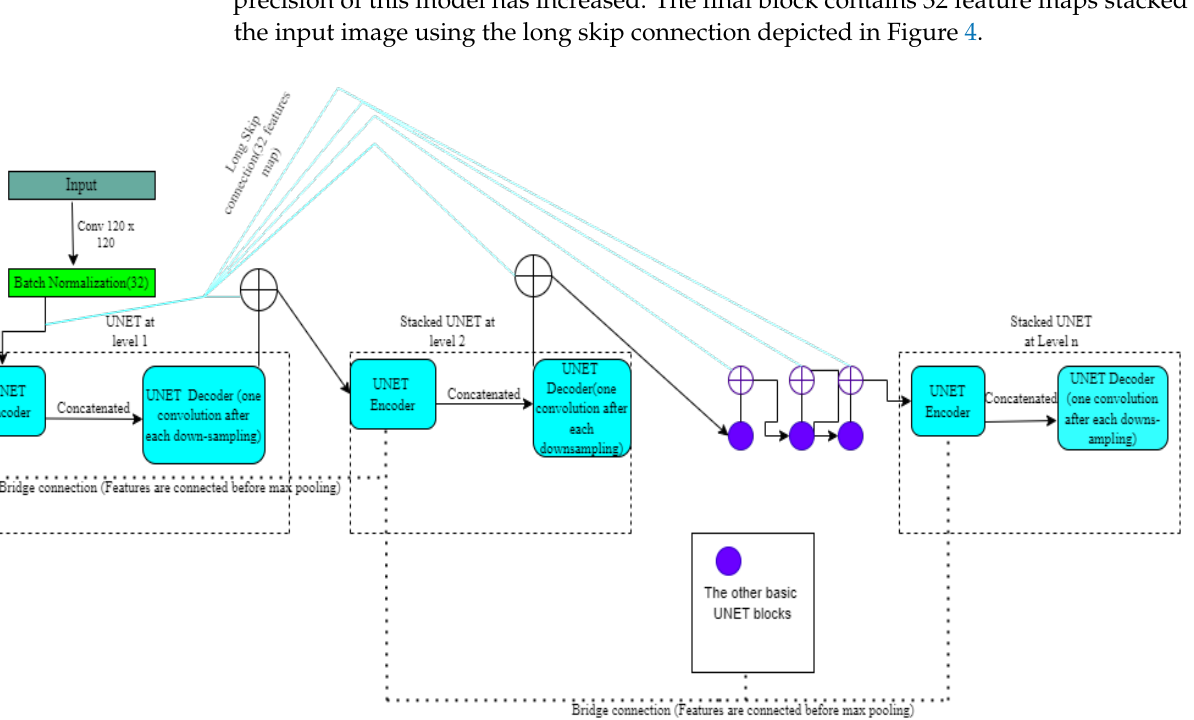
Figure 5. WorkFlow of VFR.